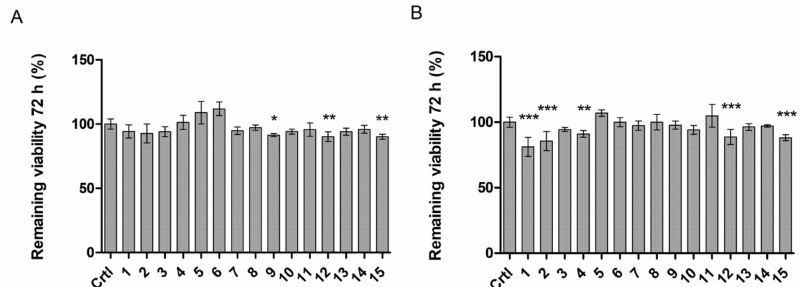
Figure 4. The remaining cell viability (%) after 72 h incubation of ( A ) 50 µ M or ( B ) 100 µ M LAT1- utilizing compounds 1 – 15 with immortalized mouse microglia (BV2 cells). The data are expressed as mean ± SD, n = 3–6 and asterisk denotes a statistically significant difference compared to the untreated control (crtl) cells (* p < 0.05, ** p < 0.01, *** p < 0.001), one-way ANOVA followed by Dunnett’s